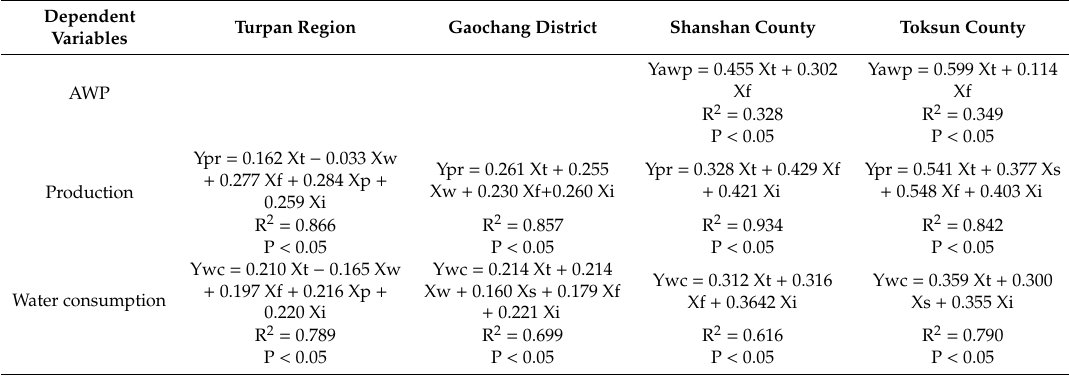
Table 3. Multiple linear regression equations for AWP, production and total water consumption in whole Turpan and three